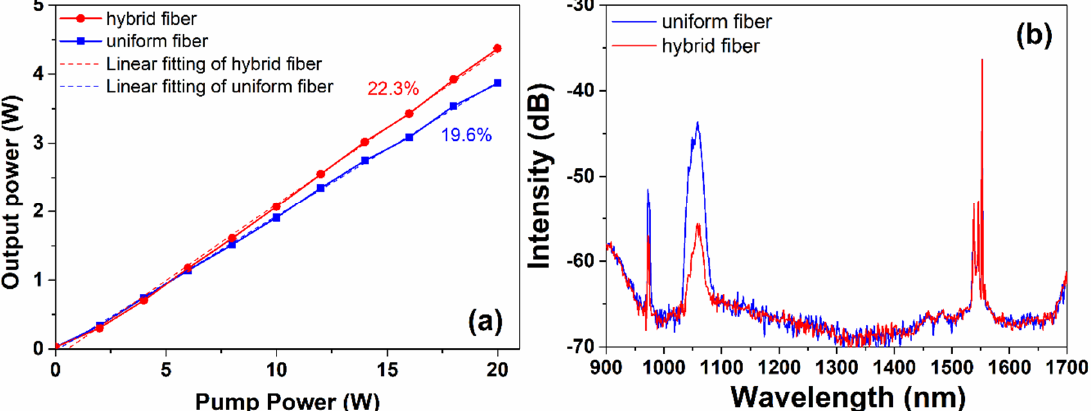
Figure 4. (a) The power scaling of the hybrid and uniform EYDF amplifier. (b) The output spectra of the hybrid and Figure 4. ( a ) The power scaling of the hybrid and uniform EYDF amplifier. ( b ) The output spectra of the hybrid and uniform uniform fiber amplifier at the maximum output power in the 900 to 1700 nm region. fiber amplifier at the maximum output power in the 900 to 1700 nm